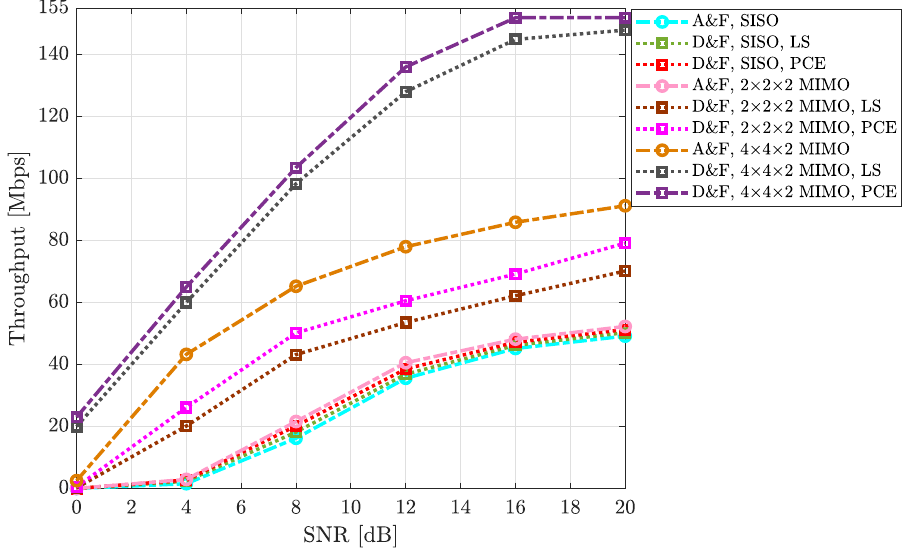
Figure 13. Throughput vs. SNR of the cooperative system; 256-QAM